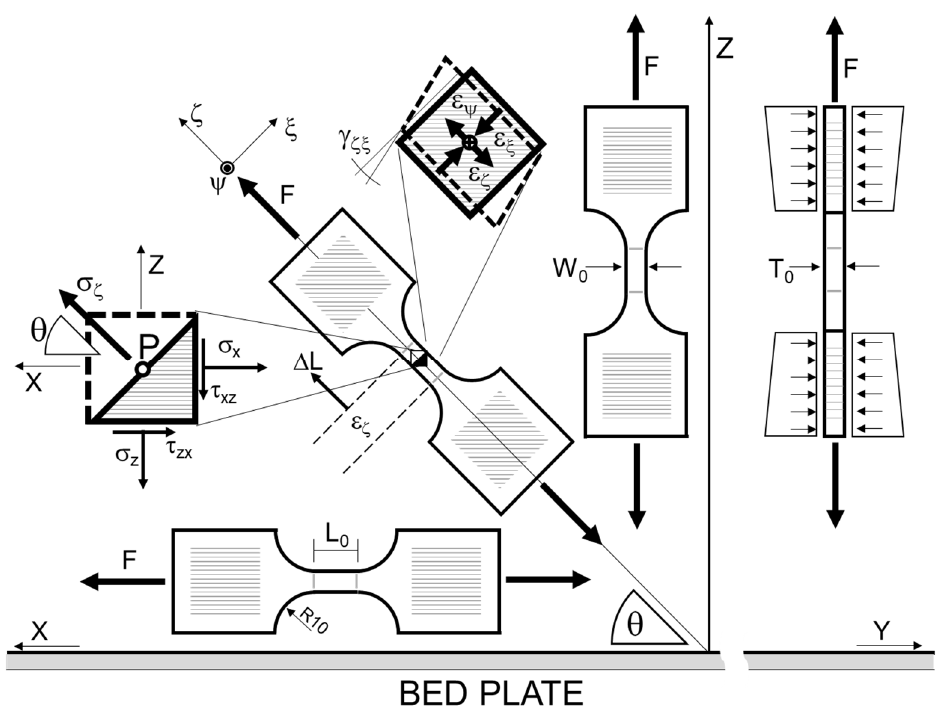
Figure 2. Representation of specimens with definitions of the printer reference system (XYZ) and testing reference system ( ζψξ ).